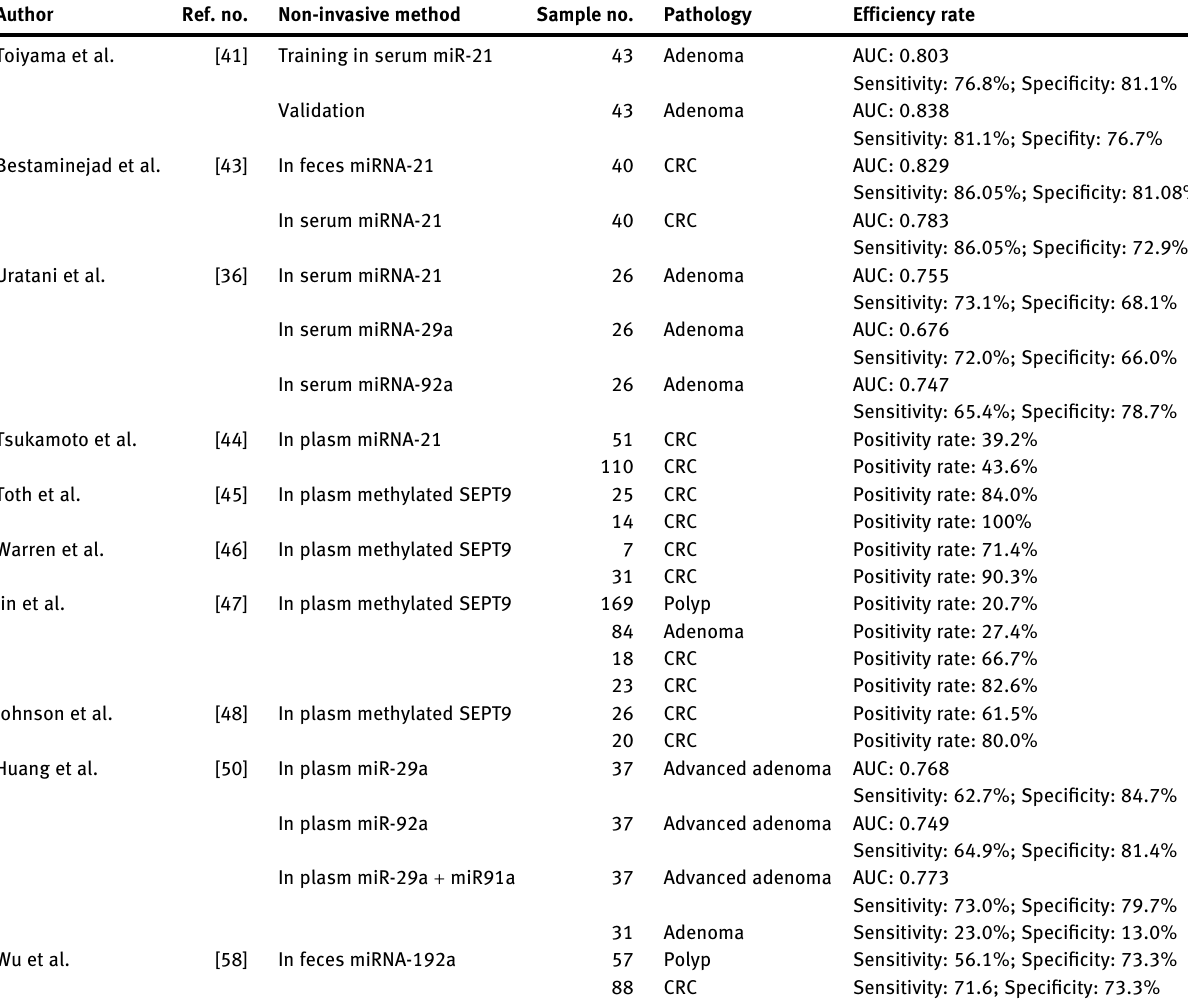
Table  : Noninvasive cost-effective molecular markers in both early stage CRCs and precancerous lesions. Ref.